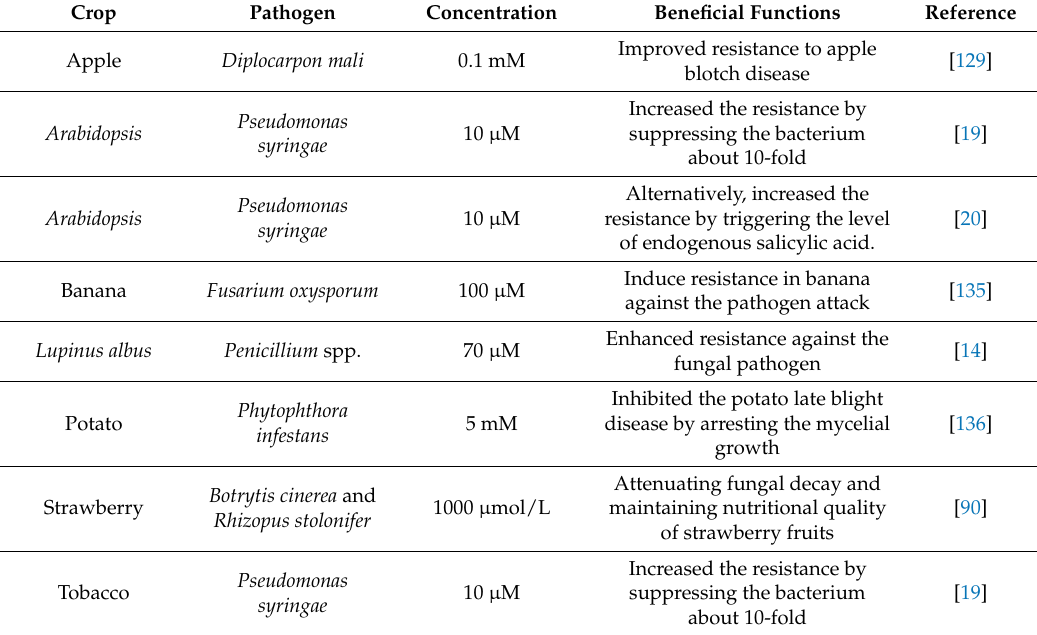
Table 4. Defense mechanism induced by melatonin against biotic stresses in different plants. Crop